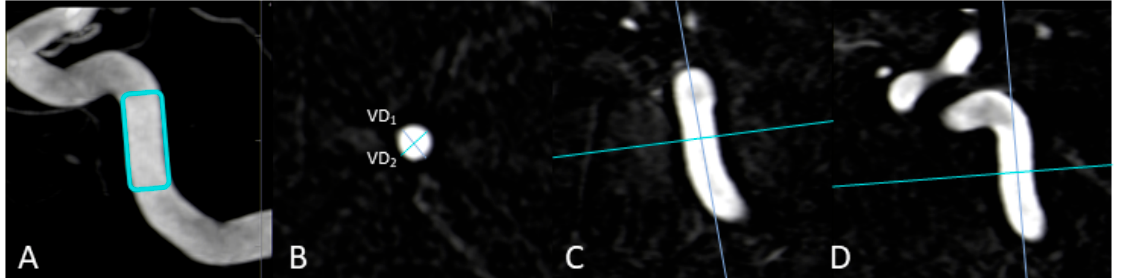
Figure 1. Exemplary measurement of a vessel-geometry-index (VGI) in a 3D-DSA dataset. In this anterior circulation case, the vessel diameters (VD 1 ; VD 2 ) of the ICA ( B ) are determined using multiplanar reconstructions at the level of the C4 segment ( A ) in an axial plane ( B ) after precise alignment of the vessel ( C , D ). In the end, the ratio of VD1 to VD 2 enables the estimation of the VGI (VGI = VD 1 /VD 2 ).